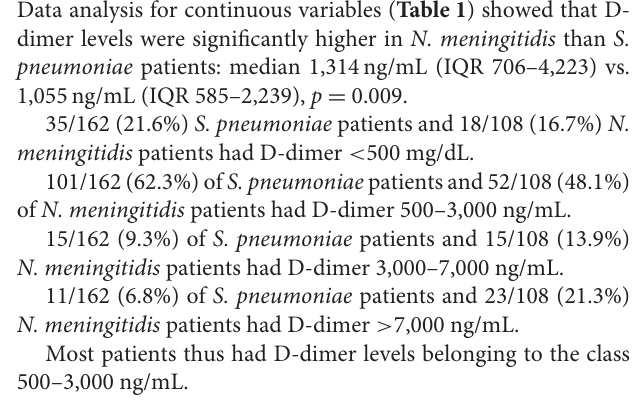
Data analysis for continuous variables ( Table 1 ) showed that D- dimer levels were significantly higher in N. meningitidis than S.